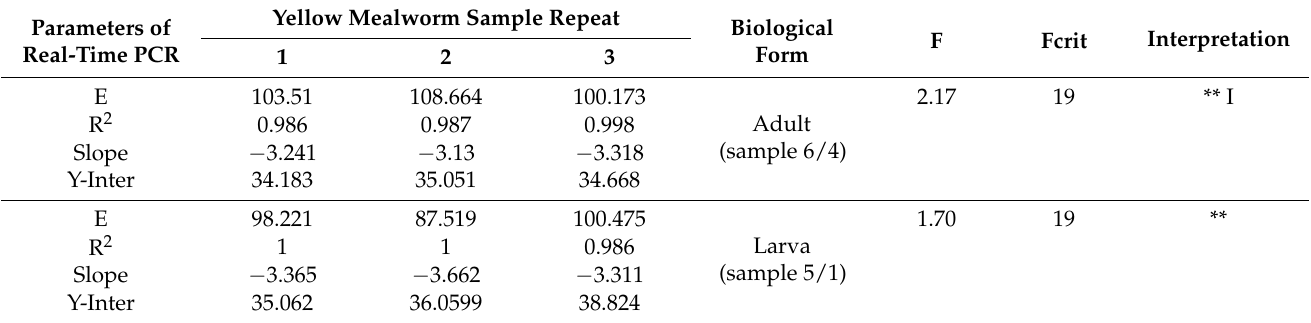
Table 7. Inter-laboratory validation results of the real-time PCR system using standard curves for three different samples—parameters of standard